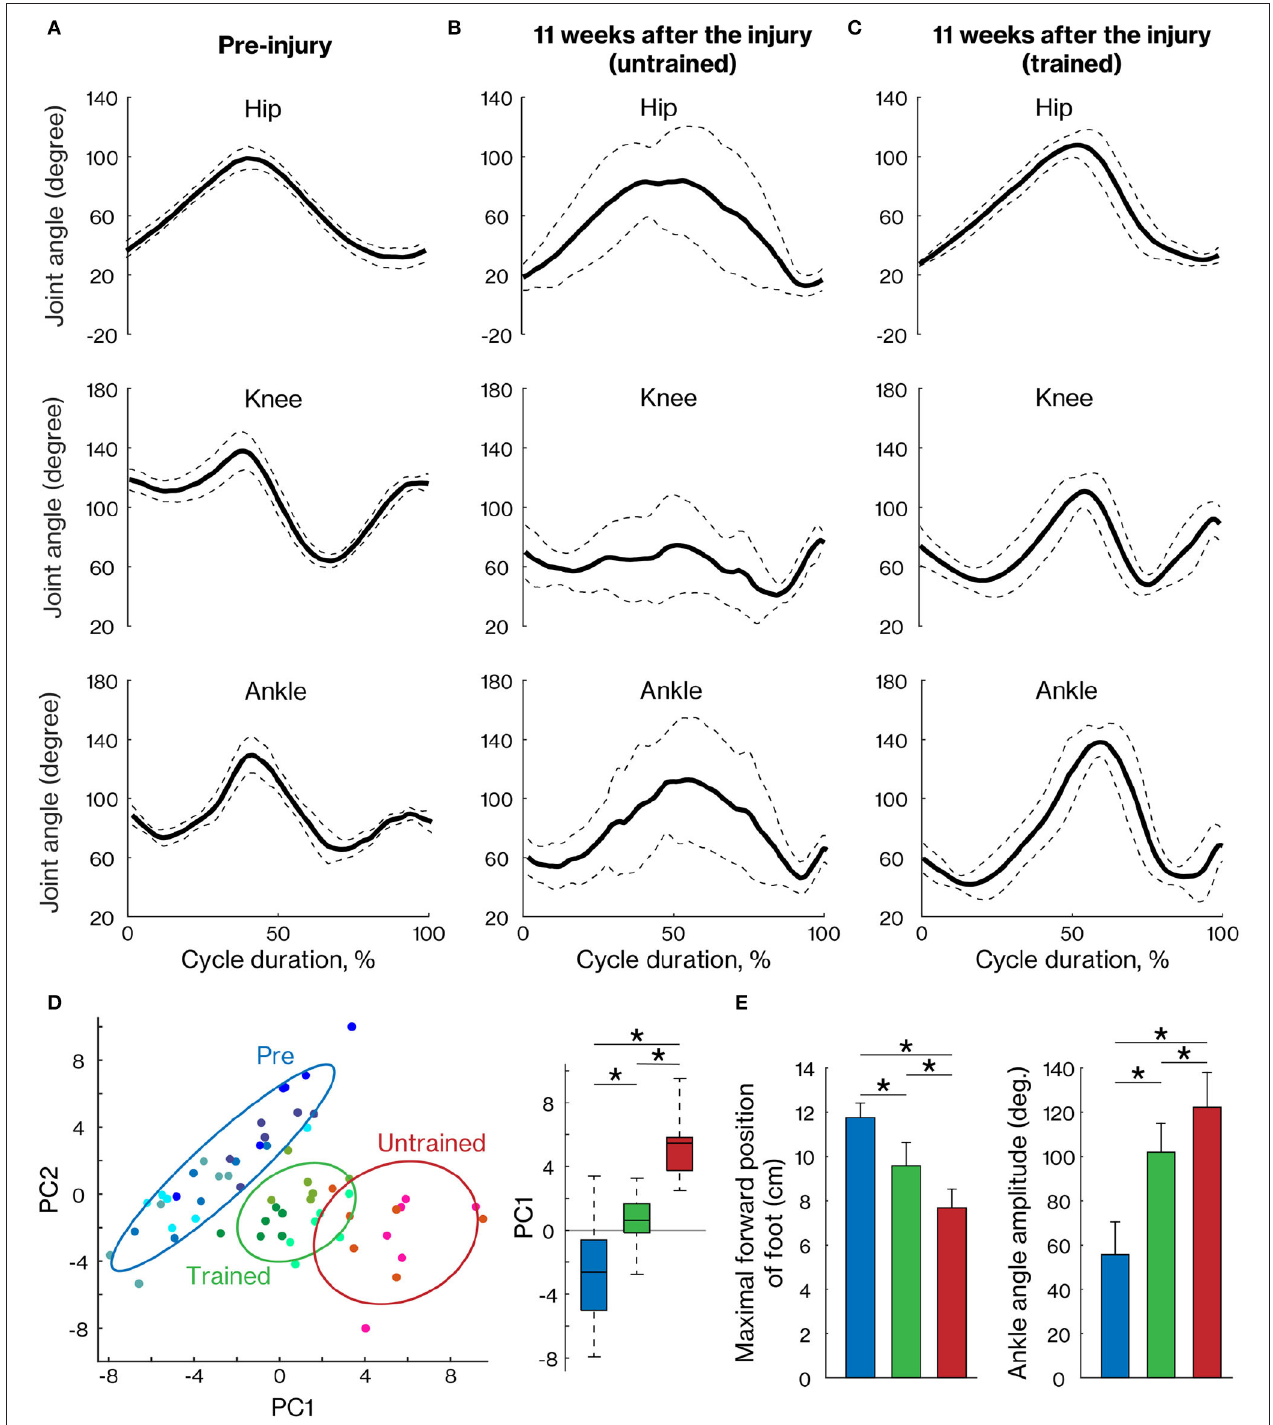
FIGURE 4 | Comparison of the right hindlimb locomotor pattern between trained and untrained groups. The mean ( ± SD) of angular excursion of the three right hindlimb joints during quadrupedal locomotion in pre-injury (A) and 11 weeks after injury in untrained (B) and trained groups (C) . The solid and dotted lines indicate the mean and SD, respectively. (D) The plane was created by PC1 and PC2 (left) and also by the box plots of PC1 scores (right), which were calculated with 47 kinematic parameters. Each plot indicates each cycle data. Least-squares circles help visualize the clusters. Blue, green, and red indicate the pre-training, trained, and untrained groups, respectively. (E) Representative kinematic parameters with a high loading factor of PC1. * < 0.05; one-way ANOVA followed by Tukey post hoc comparison.